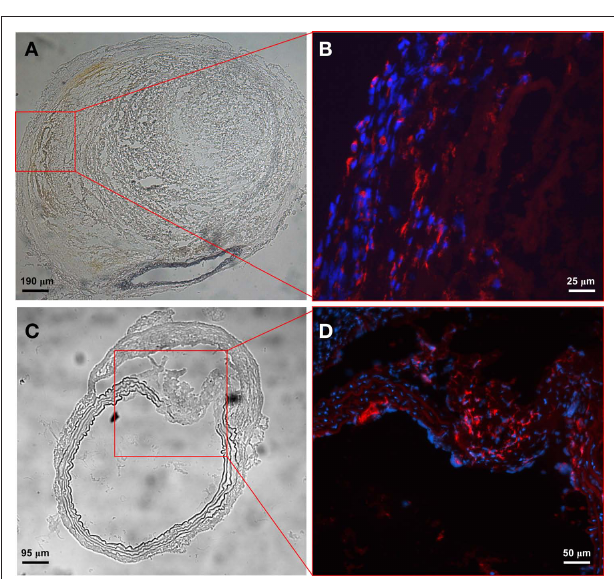
FIguRE 5 | Ang II-induced AAA volume measurements correlate with AAA severity. (A) Reconstructed volumes of abdominal aorta without (left panel of three representative aortas) and with AAA formation (right panel of three representative aortas). (B) Quantification of volume in a landmarked suprarenal segment. * P < 0.01 between Ang II infusion without AAA formation ( n = 5) and with Ang II-induced AAA formation ( n = 6). (C) Linear regression analysis shows strong correlation between aortic 3D volume and Daugherty’s AAA severity classification ( P < 0.0001). The dotted lines represent 95% confidence intervals.